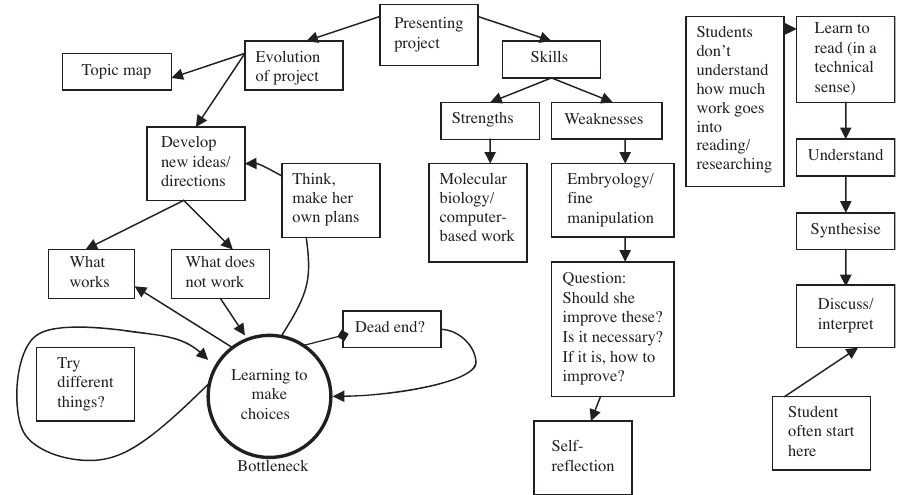
Figure 6. Second supervisor map of what a Ph.D.